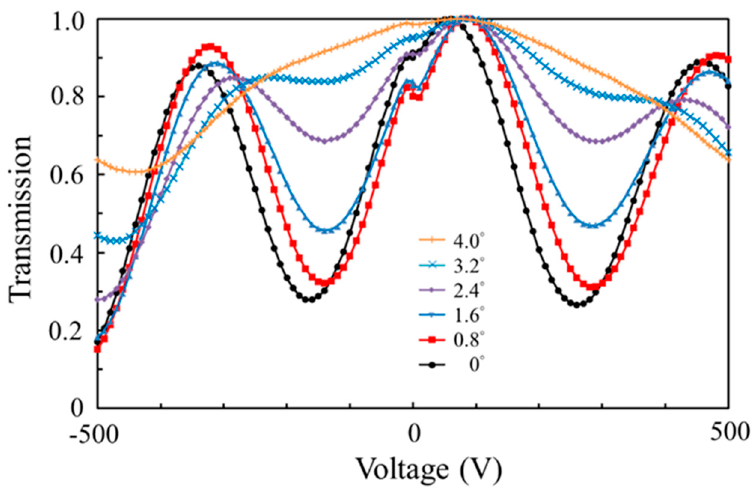
Figure 5. Transmission curves for different incident angles. The 0 ◦ curve shows that the incident angle is right at the Bragg angle (0.69 ◦ ). As the incident angle deviated from the Bragg angle, the dual-grating EOPBD became inefficient.